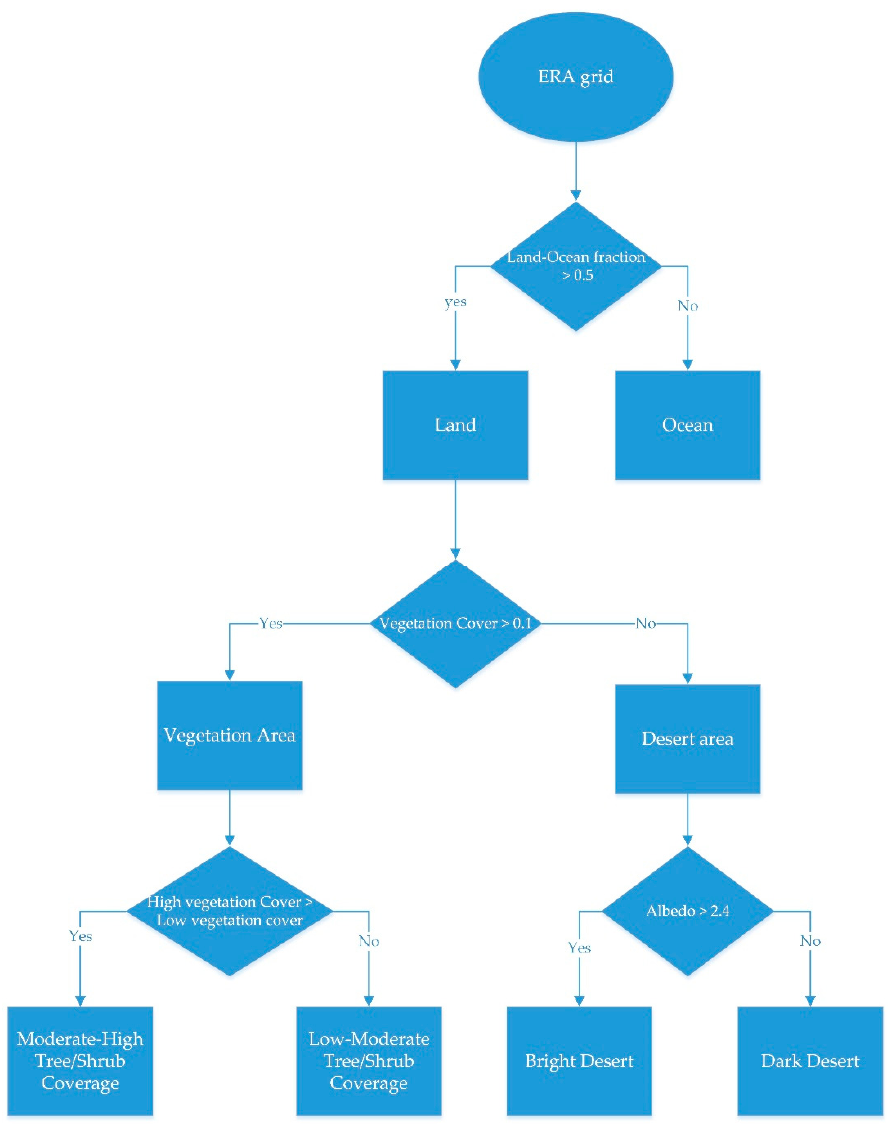
Figure 2. The flow chart to identify the surface type from ERA5 data.